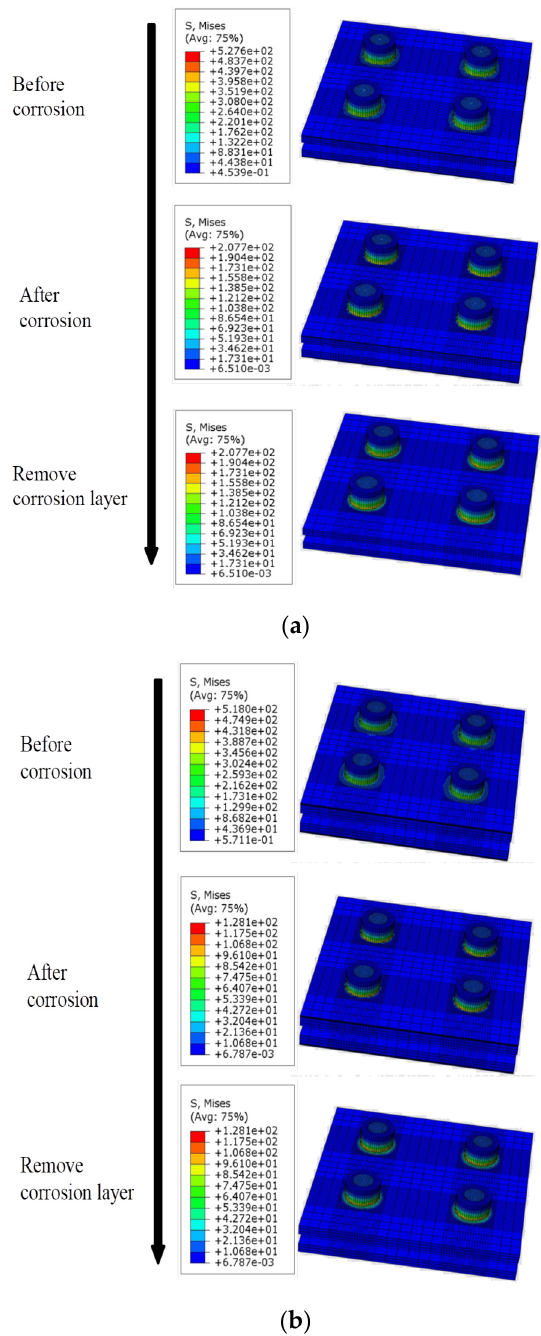
Figure 17. Stress distribution state of connections. ( a ) Stress distribution state of TX series; ( b ) Stress distribution state of TY series.